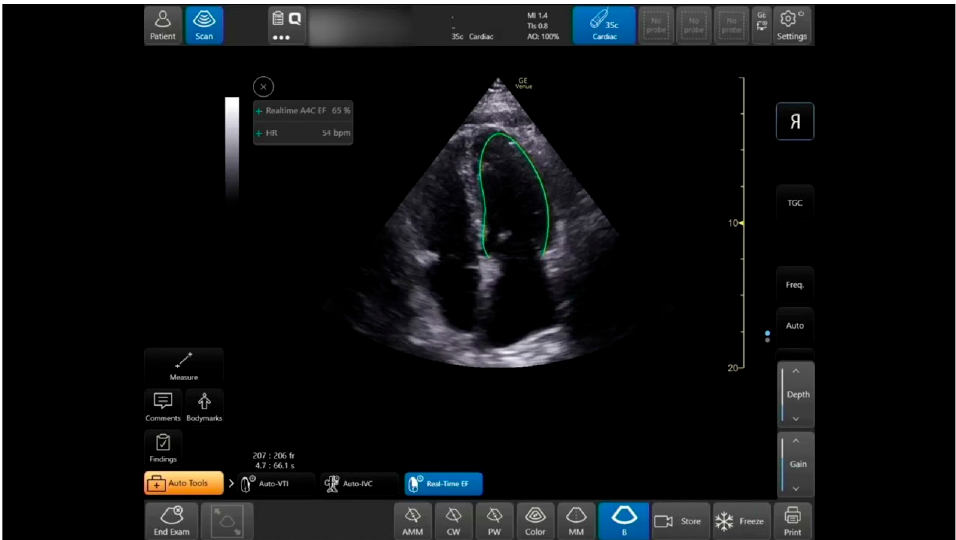
Figure 2. Auto EF tool: in Apical-4-Chamber-View: auto LV outlining in systole and diastole, measurements, and data display.